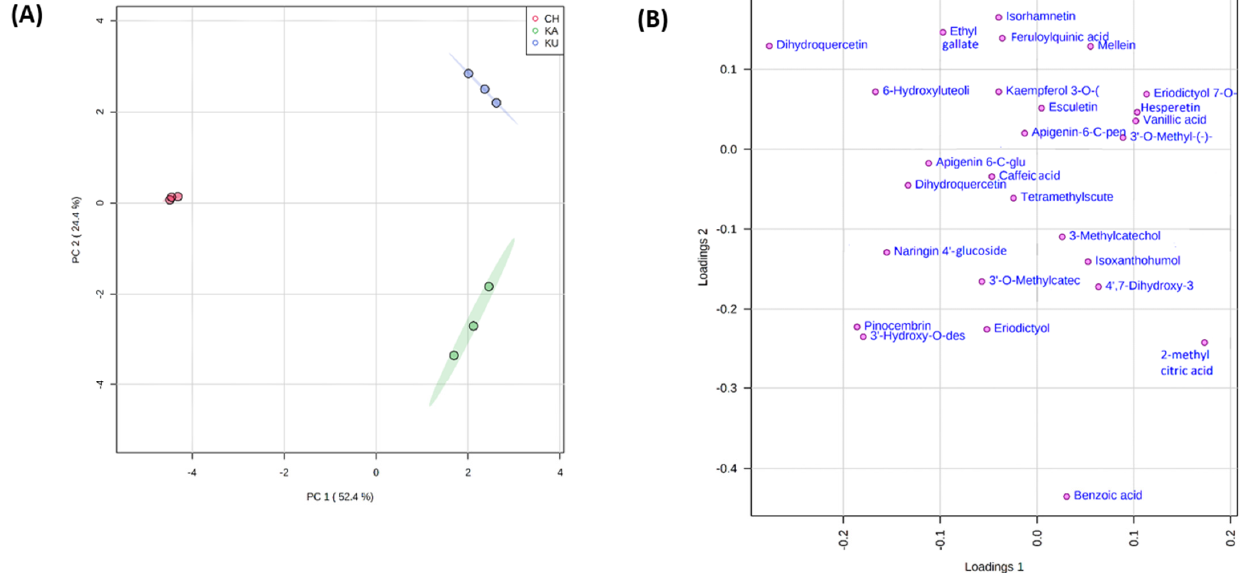
Figure 3. Principal component analysis (PCA) of red rice phenolic metabolites ( A ) PCA score plot ( B ) PCA loading plot.